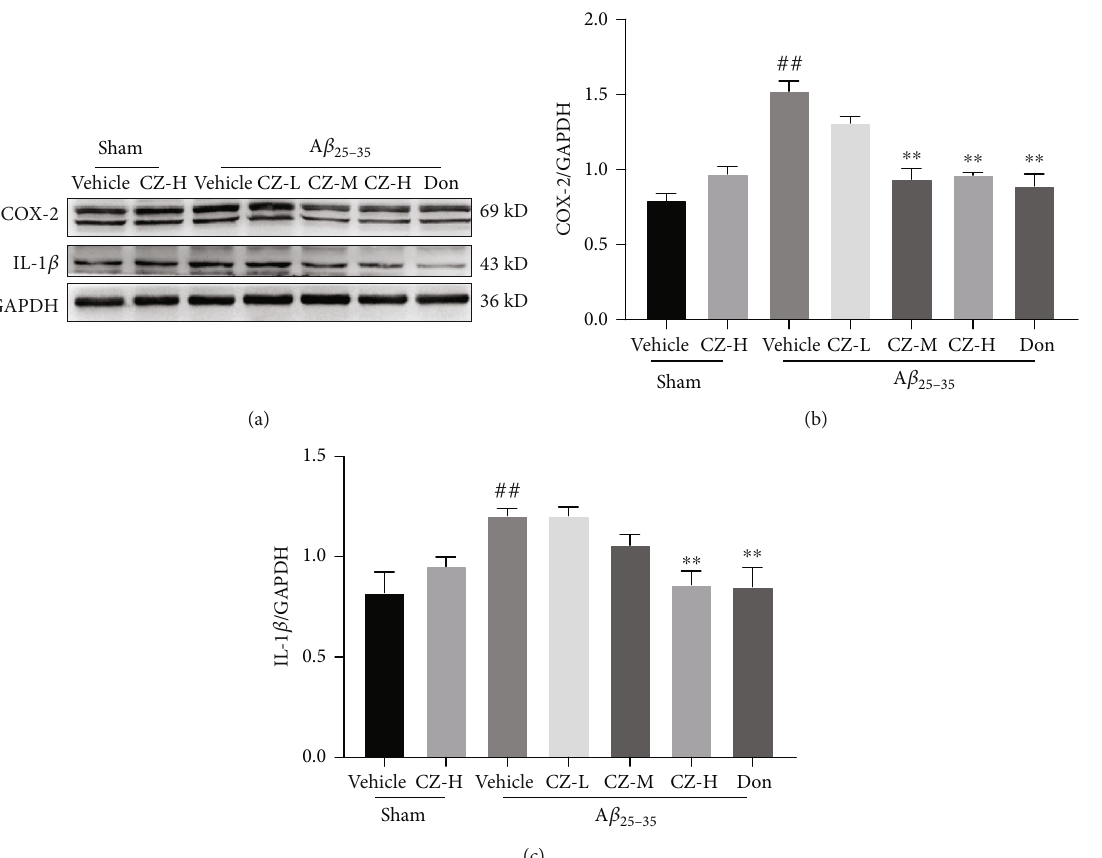
Figure 4: CZYH decreases the expression of in fl ammatory factors in the hippocampus of A β band of COX-2 and IL-1 β protein expression. Quanti fi cation of (b) COX-2 and (c) IL-1 β protein expression levels. Values are means ± SEM , n = 5 . # P < 0 : 05 and ## P < 0 : 01 vs. sham; ∗ P < 0 : 05 and ∗∗ P < 0 : 01 vs. A β